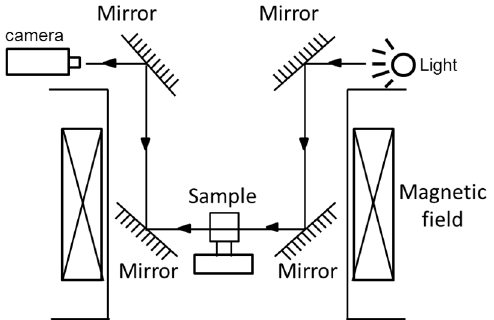
Figure 6. Schematic diagram of the symmetrical device for simultaneously observing protein crystal growth in two locations [51].